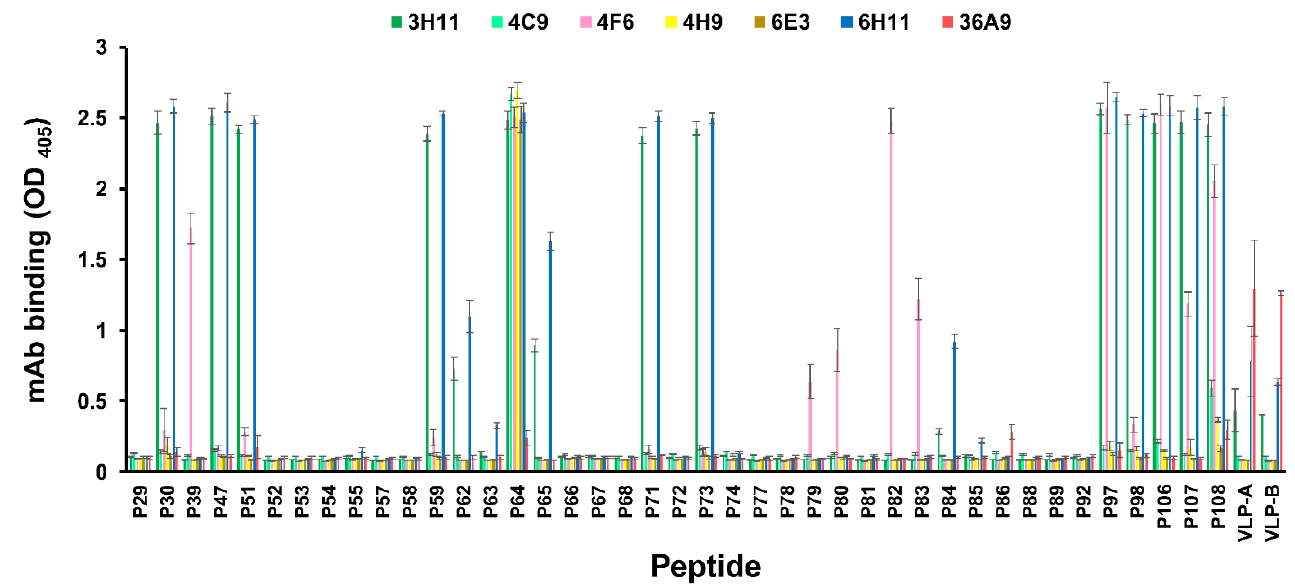
Figure 1. Mapping of the linear and minimal epitopes for anti-capsid peptide (peptide P64) mAbs binding. Anti-P64 mAbs bound the linear peptide spanning from residues 205 to 233. The mAb binding was tested by using an iELISA. Peptides contained the sequence of the capsid protein between residues 205 and 233, associated 10-mer peptides, and truncated derivatives (as shown in Table 1). The experiments were performed three times. Data represent the mean ± standard error (SE).